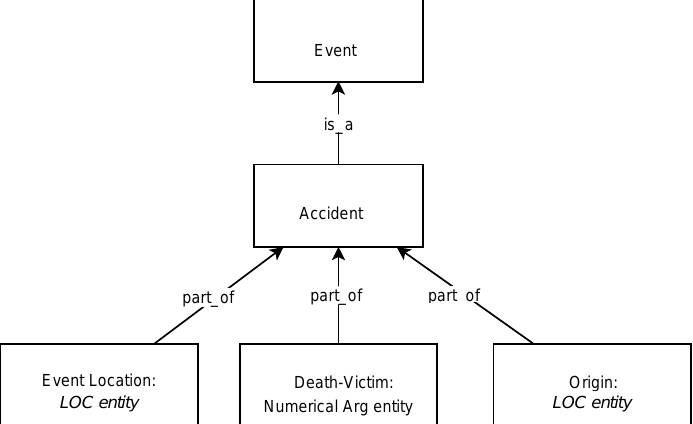
Figure 3. Sample Ontology of Vehicle Accident. Events can be modeled as grouping of various semantic roles and their arguments, forming templates for different types of events. For example, the Accident event has two semantic roles regarding location entity and one numerical argument.